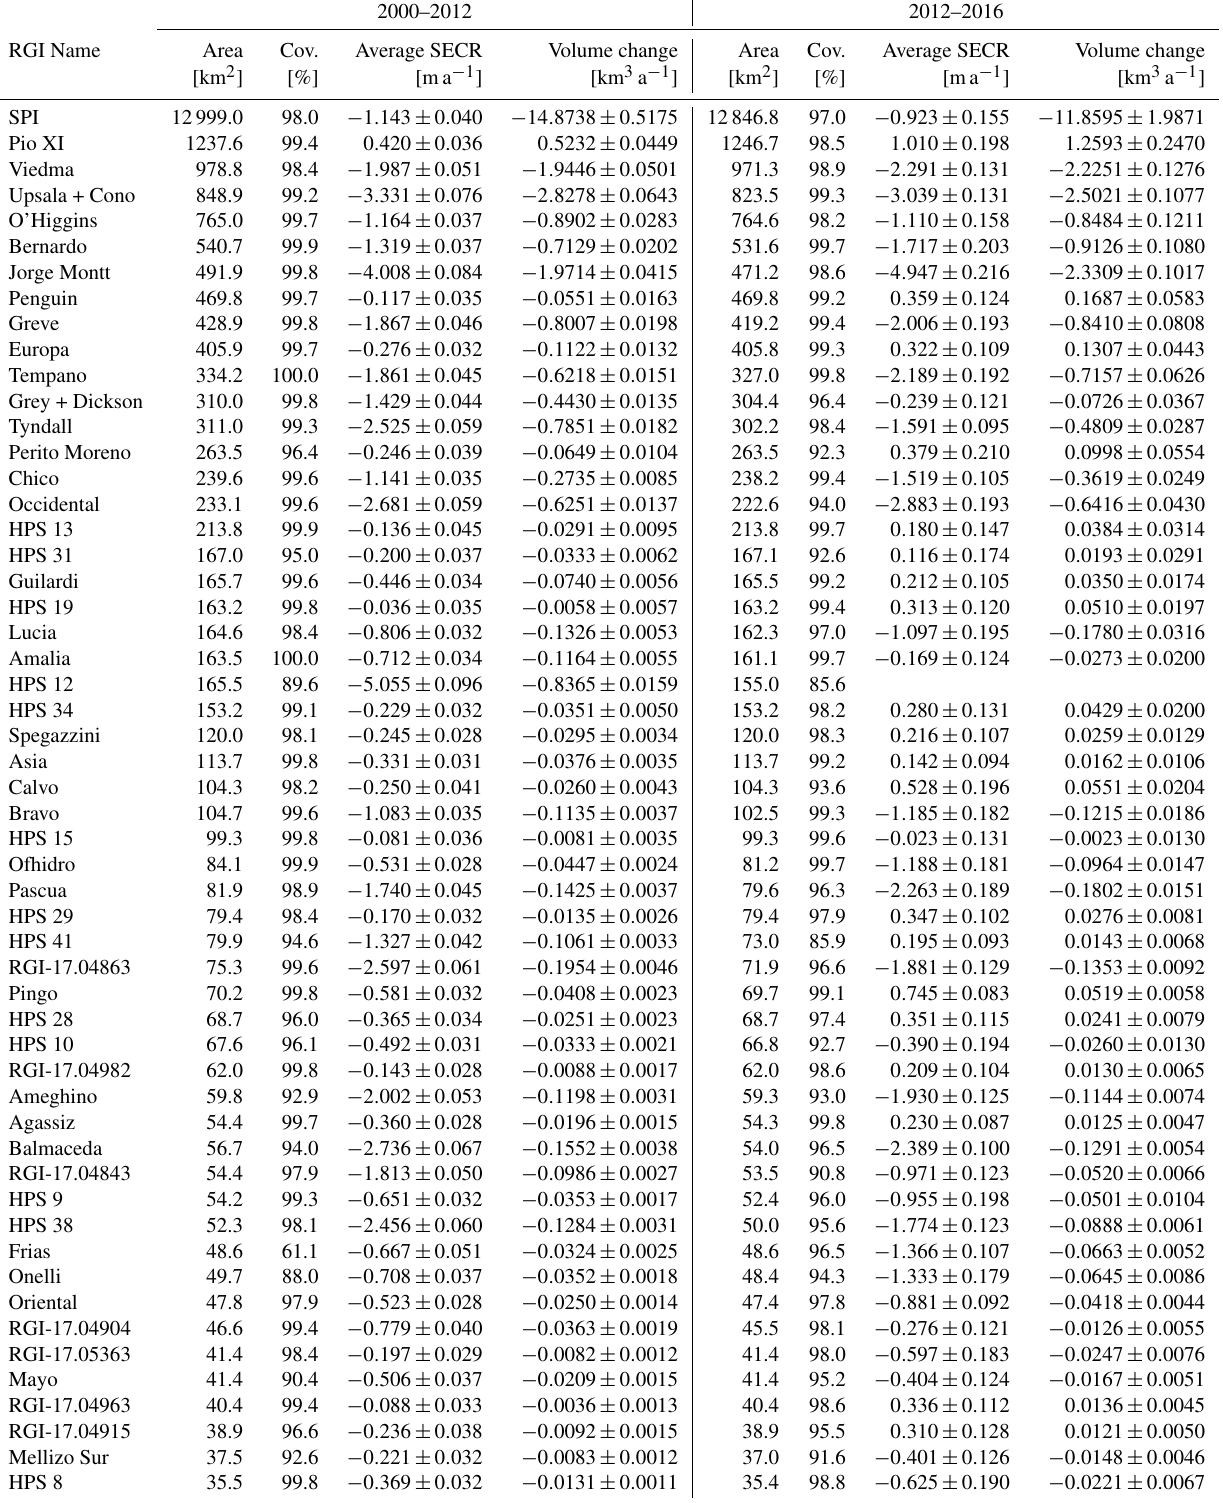
Table 3. Average surface elevation change rate (SECR) and volume change rate (VCR) for SPI and its glaciers larger than 35 km 2 for the two epochs. The reported area refers to the beginning of the epoch; the coverage of the SECR map is also reported. Subaqueous ice changes are not included. The list is continued for glaciers up to 9 km 2 in Table